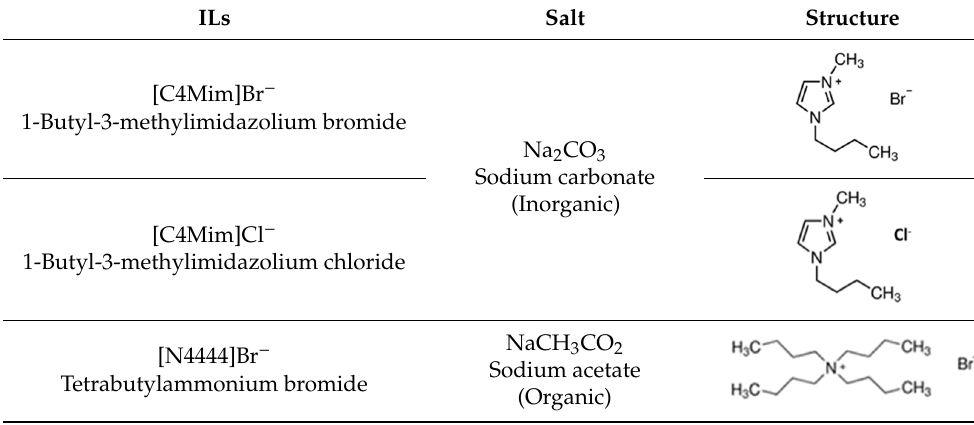
Table 1. Description of the selected ionic liquids (ILs) associated with the kosmotropic salt buffer, enabling a diphasic system.